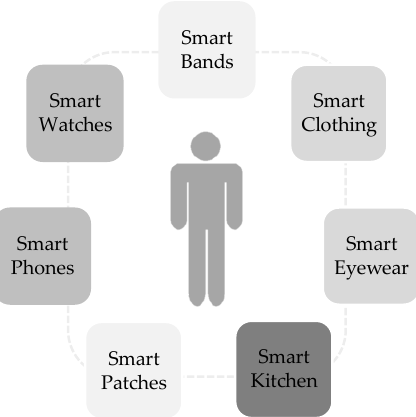
Figure 2. Examples of smart digital tools for monitoring of lifestyle and physiology.